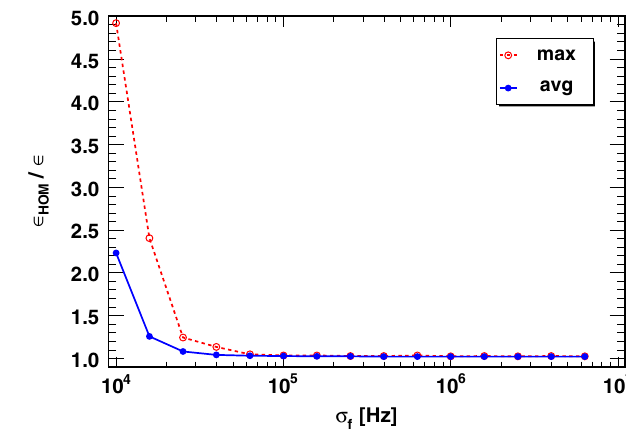
FIG. 10. Average (solid, blue) and maximum (dashed, red) . Settings: longitudinal phase space increase against the HOM frequency q spread for 100 linacs. Settings: N ¼ 100 , see Table